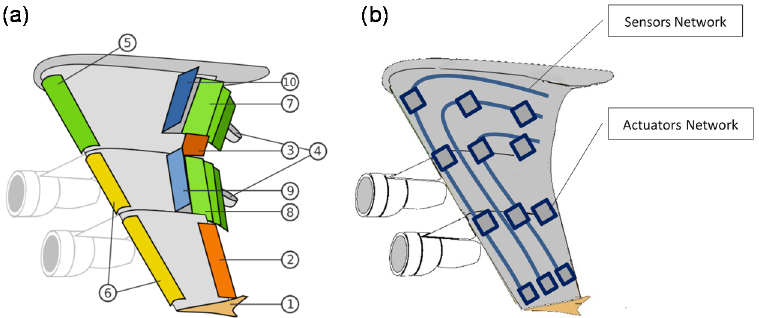
Figure 23. ( a ) Current airplanes wing with flaps and brakes and ( b ) expected nervous seamless wing.